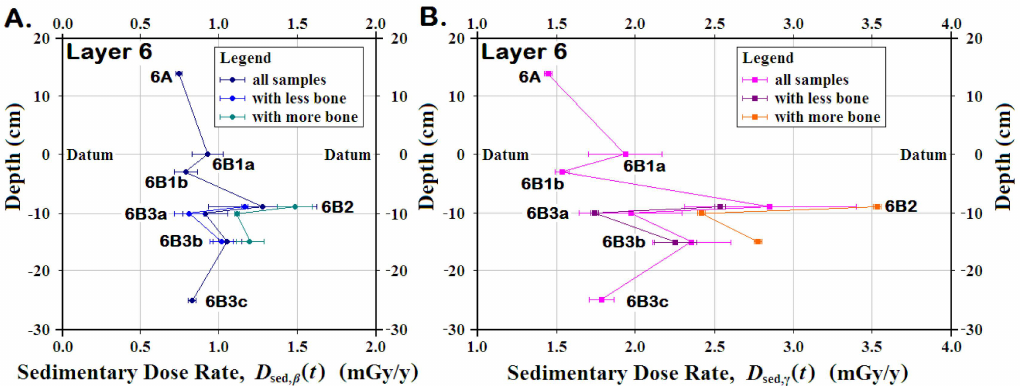
Figure 7. The e ff ect of bone in the sedimentary dose rates, D sed ( t ), at Saradj-Chuko Grotto, Russia . Within Layer 6 at Saradj-Chuko, having more bone in the sediment produced: ( A ) higher β sedimentary dose rates, D sed, β ( t ) ( B ) higher γ sedimentary dose rates, D sed, γ ( t ) Bone-rich samples had up to 0.32 mGy / y for D sed, β ( t ) and 1.0 mGy / y for D sed, β ( t ). If bone-rich samples were removed from the means for D sed, β ( t )and D sed, β ( t ), the resulting D sed, β ( t )and D sed, γ ( t ) had lower mean rates with significantly smaller uncertainties. Thus, knowing the precise locations for bone-rich sediment will increase the precision for the dose